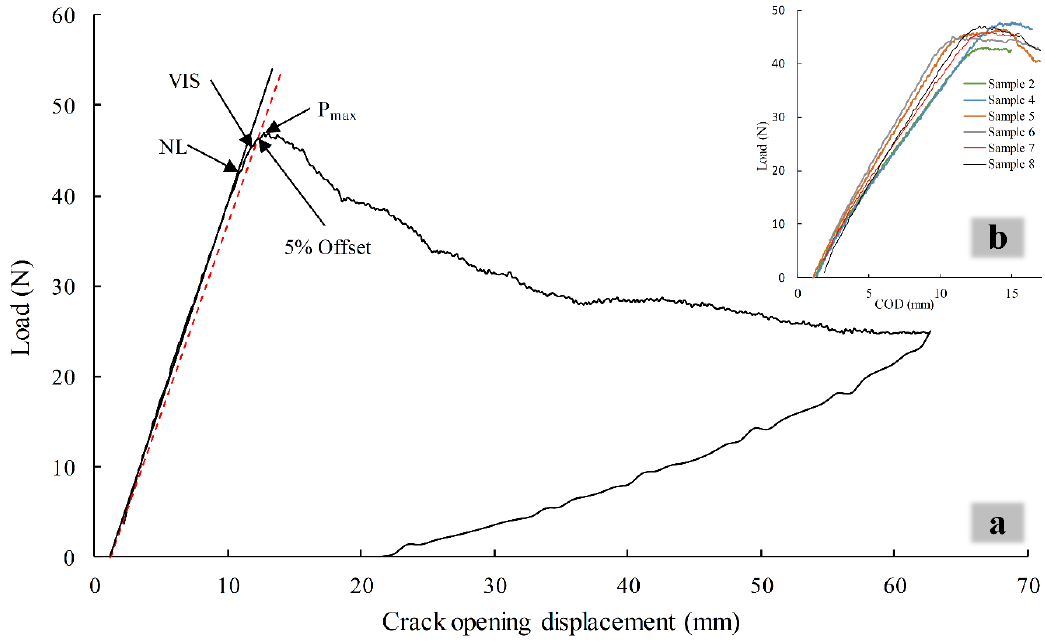
Figure 9. Load vs. crack opening displacement (COD) of the DCB specimen: ( a ) Typical loading/unloading cycle and initial G IC value measurement points, and ( b ) overall initial